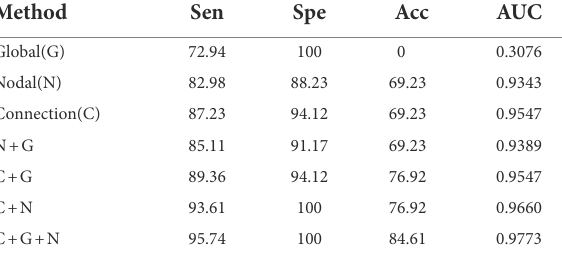
TABLE 7 Classification performance corresponding to different